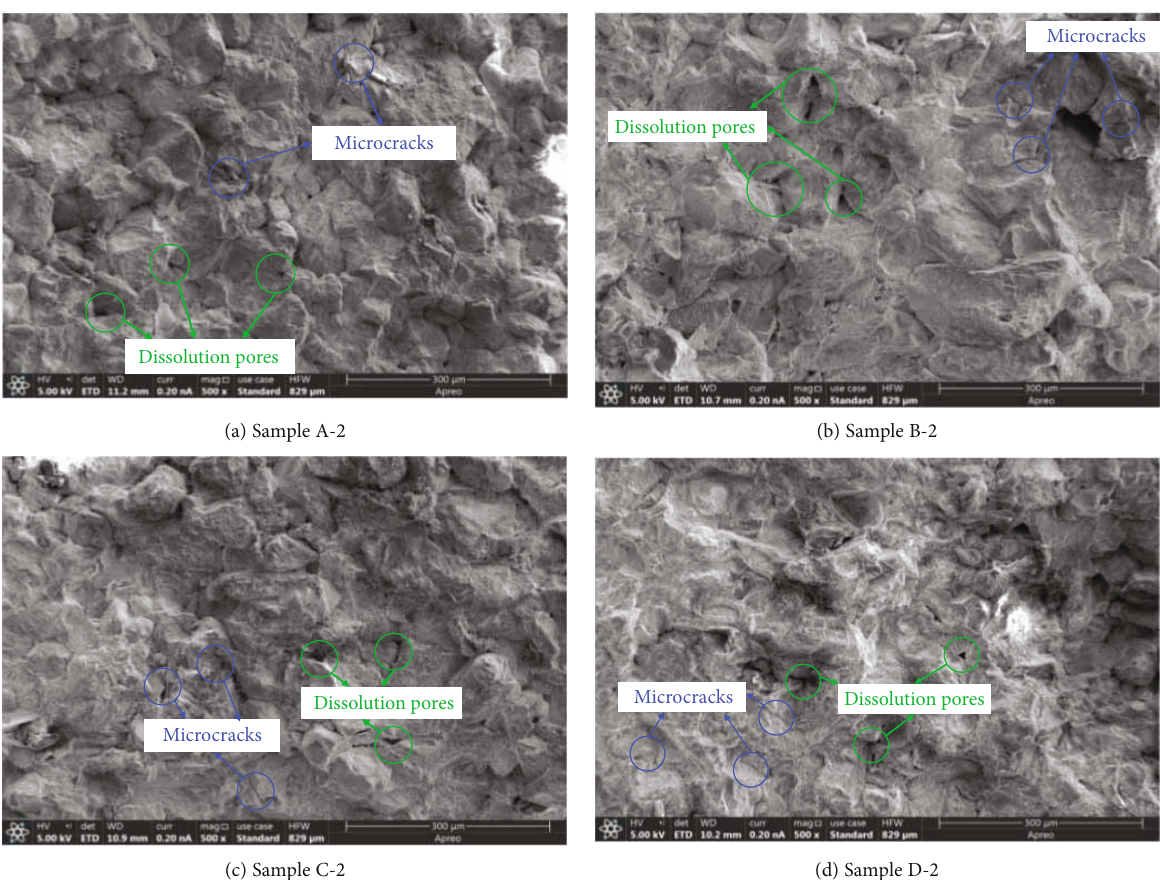
Figure 10: SEM photos of fracture surfaces on sandstone samples.